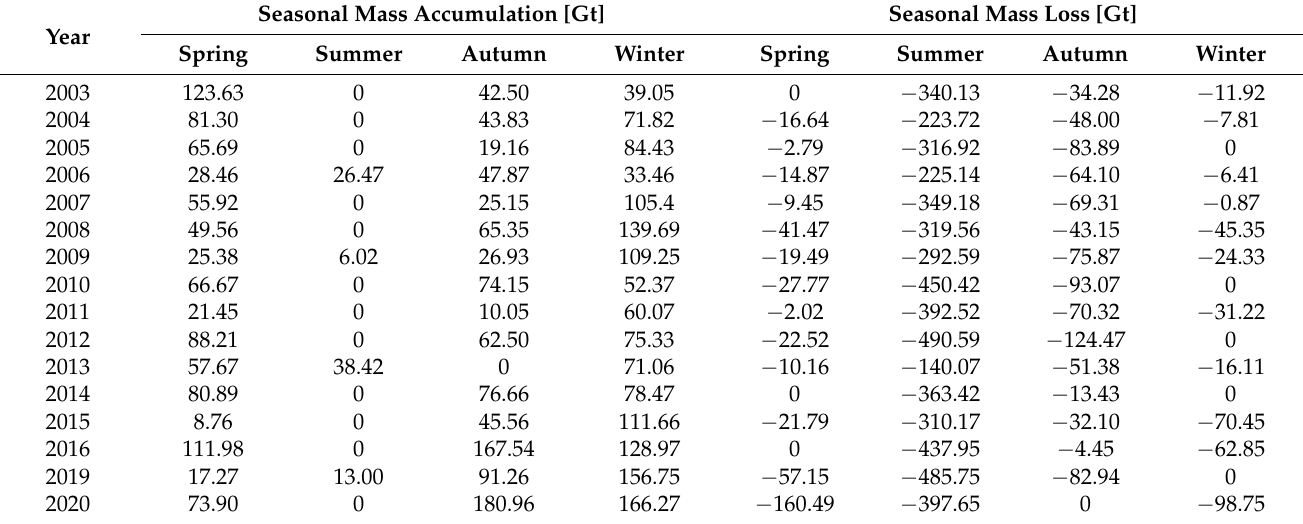
Table 1. Partitioning seasonal mass change into seasonal mass accumulation and seasonal mass loss in each